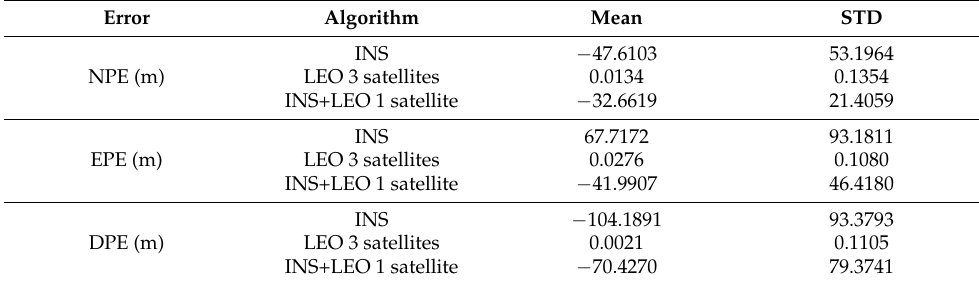
Figure 6. Single-satellite navigation and positioning results in the scenario without an altimeter. Table 2. Position error